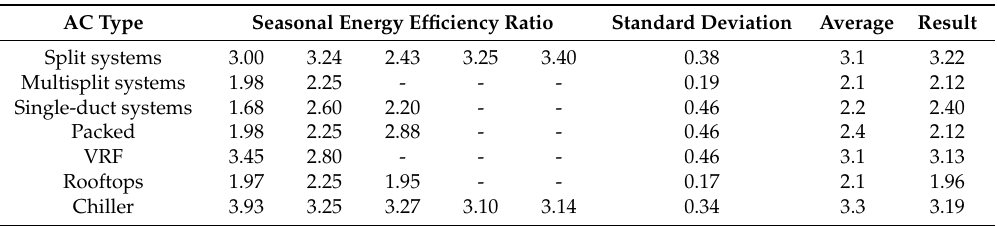
Table A5. Statistical calculations regarding the seasonal energy efficiency ratio per AC type,